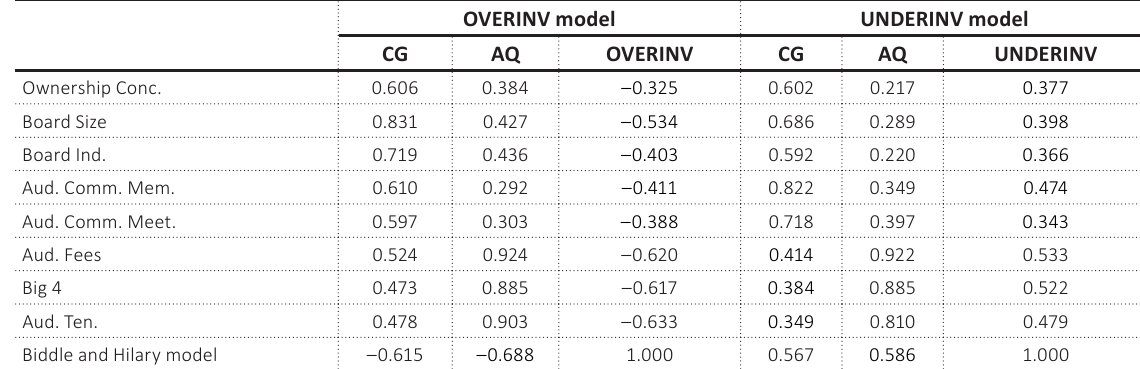
Table 4. Values of discriminant validity